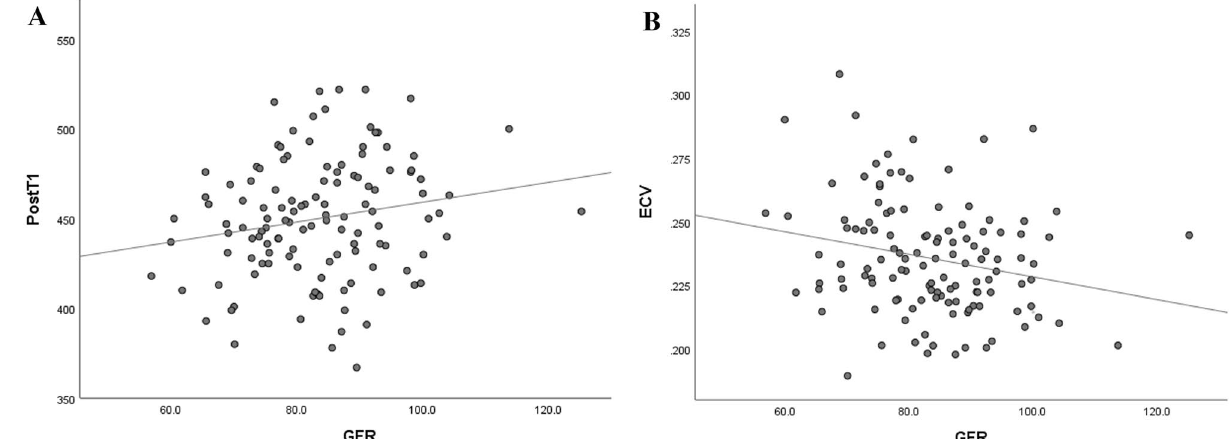
Figure 3. Relation of post-contrast T1 (PostT1) value and extracellular volume fraction (ECV) with glomerular filtration rate (GFR) in the control group. Overall PostT1 and ECV of left ventricle were proportional to GFR (A: r = 0.19, p = 0.038 for PostT1, B: r = − 0.23, p = 0.011 for